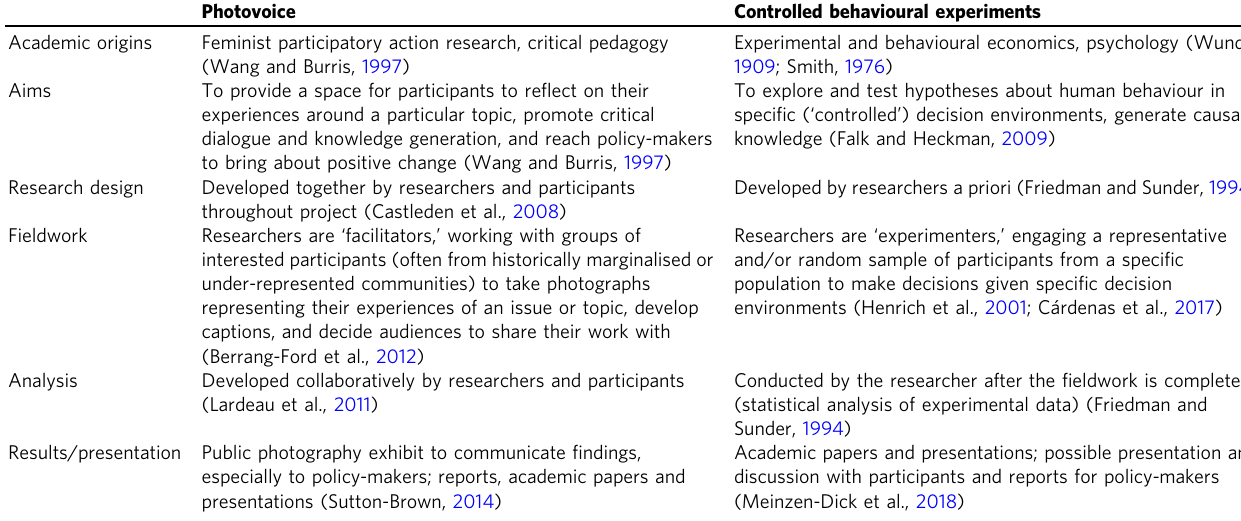
Table 2 Ideal-typical descriptions of photovoice and controlled behavioural experiments (with illustrative references).